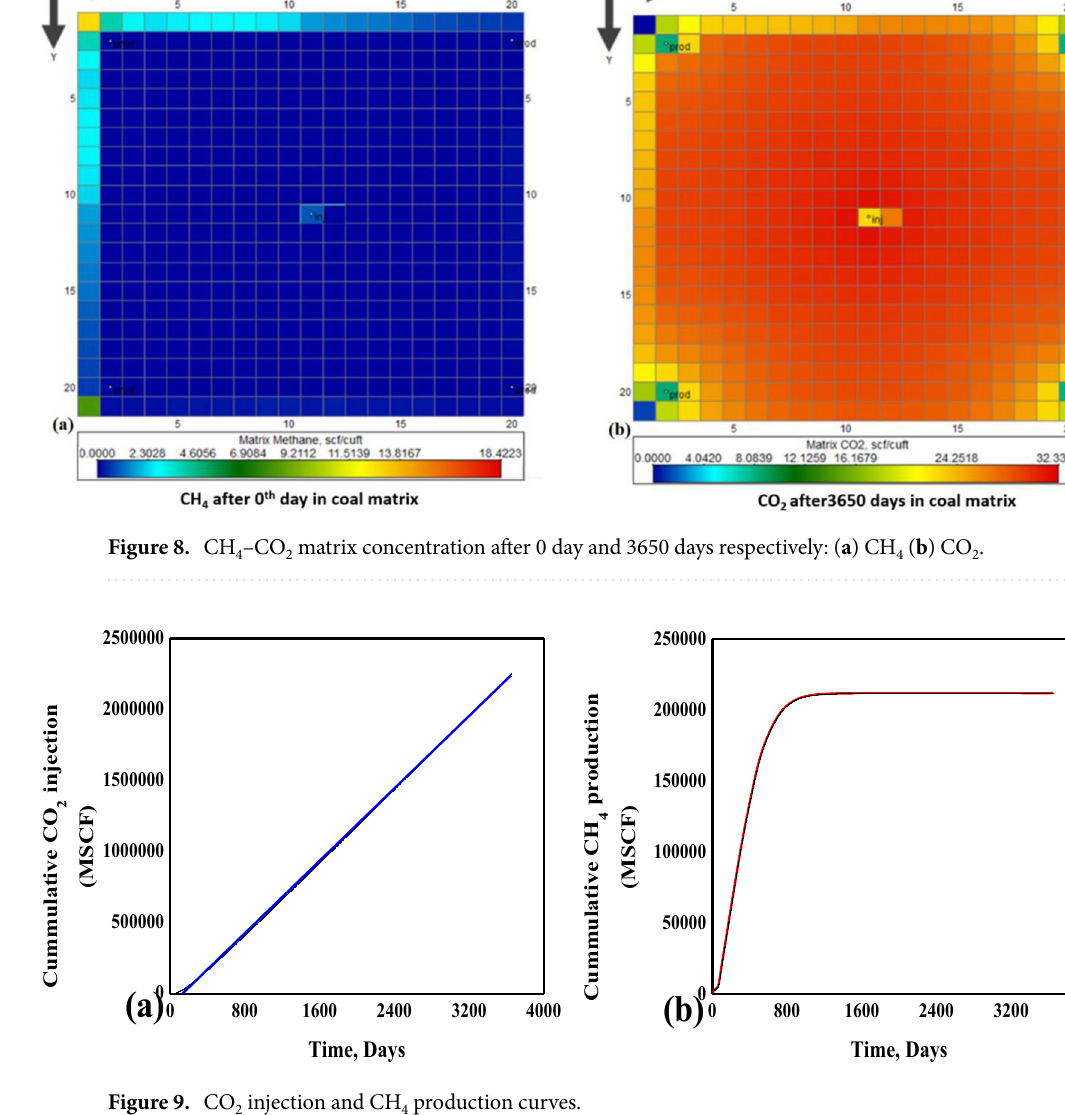
Figure 9. CO 2 injection and CH 4 production curves.